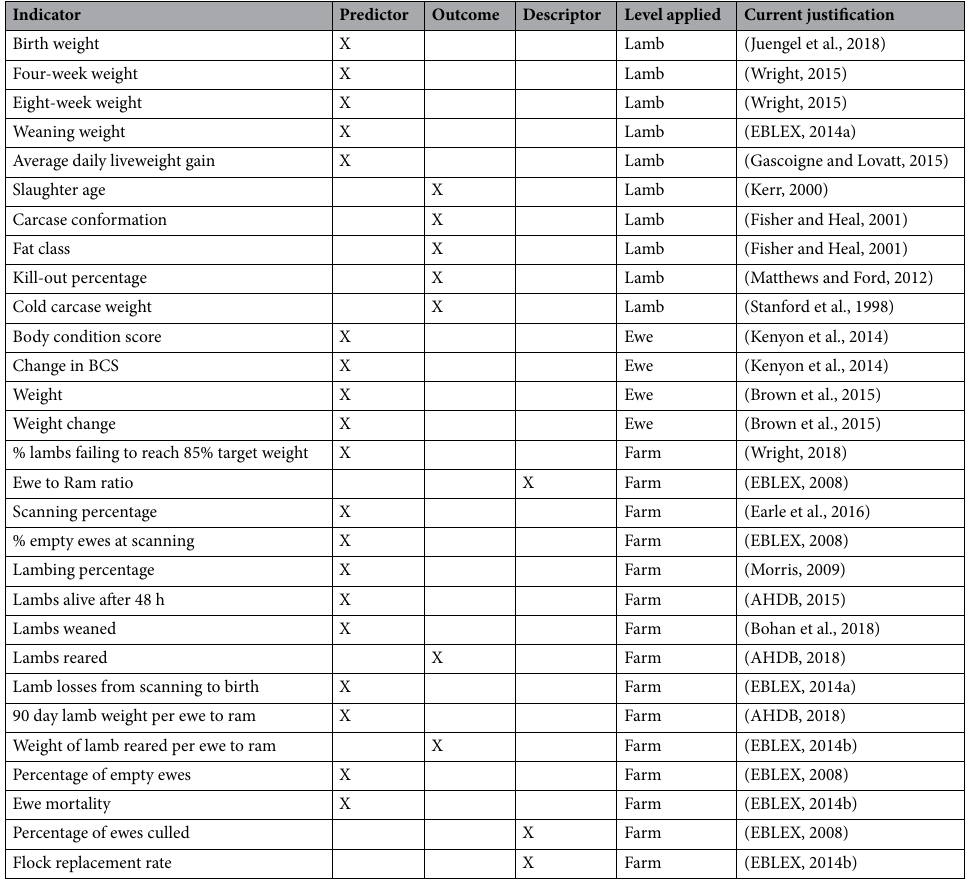
Table 1. Key performance indicators currently in common